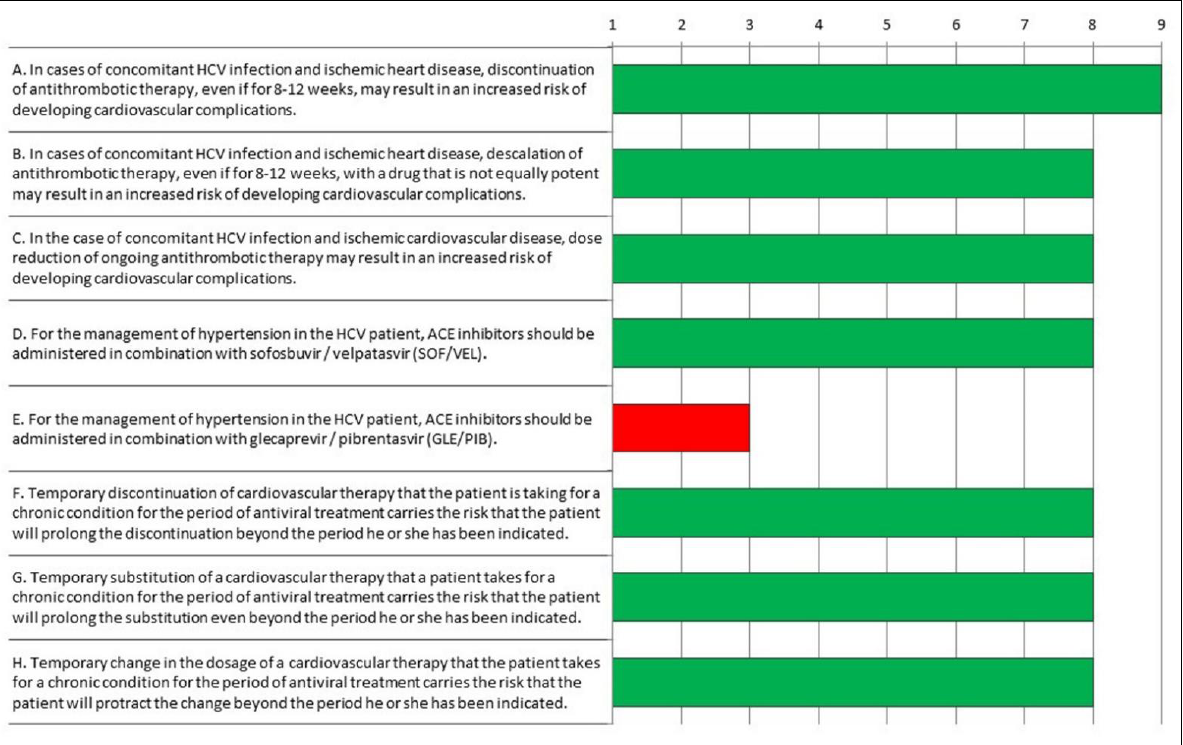
Figure 2. Appropriateness of responses to Questionnaire 2 evaluated according to the RAND/UCLA Method. Green: appropriate; red: inappropriate. Method. Green: appropriate; red: